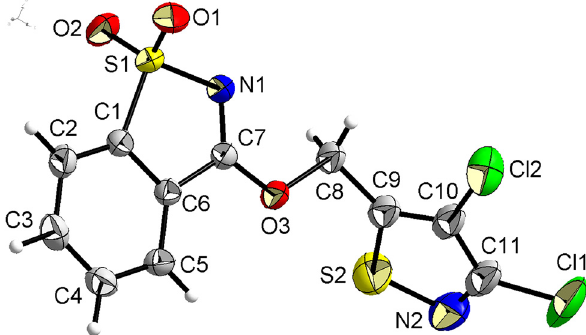
Table  : Data collection and